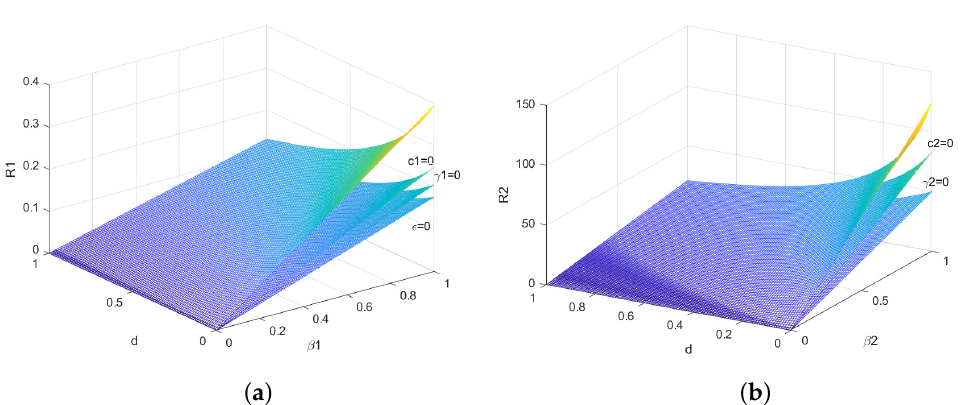
Figure 1. Relationship of the basic reproductive number and parameters. ( a ) The relationship among d , β 1 , and R 1 . ( b ) The relationship among d , β 2 , and R 2